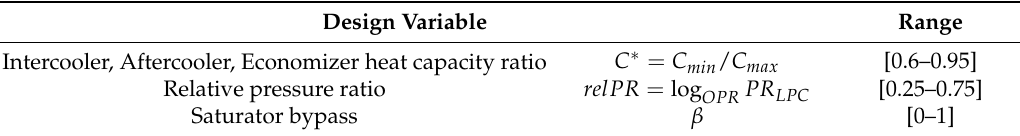
Table 2. Heat exchanger design parameters and range specfication.